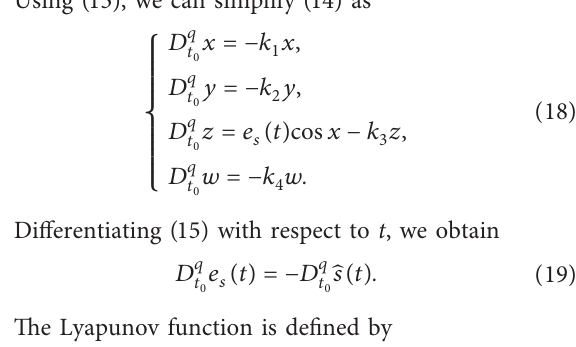
Figure 7: The flow chart for basins of